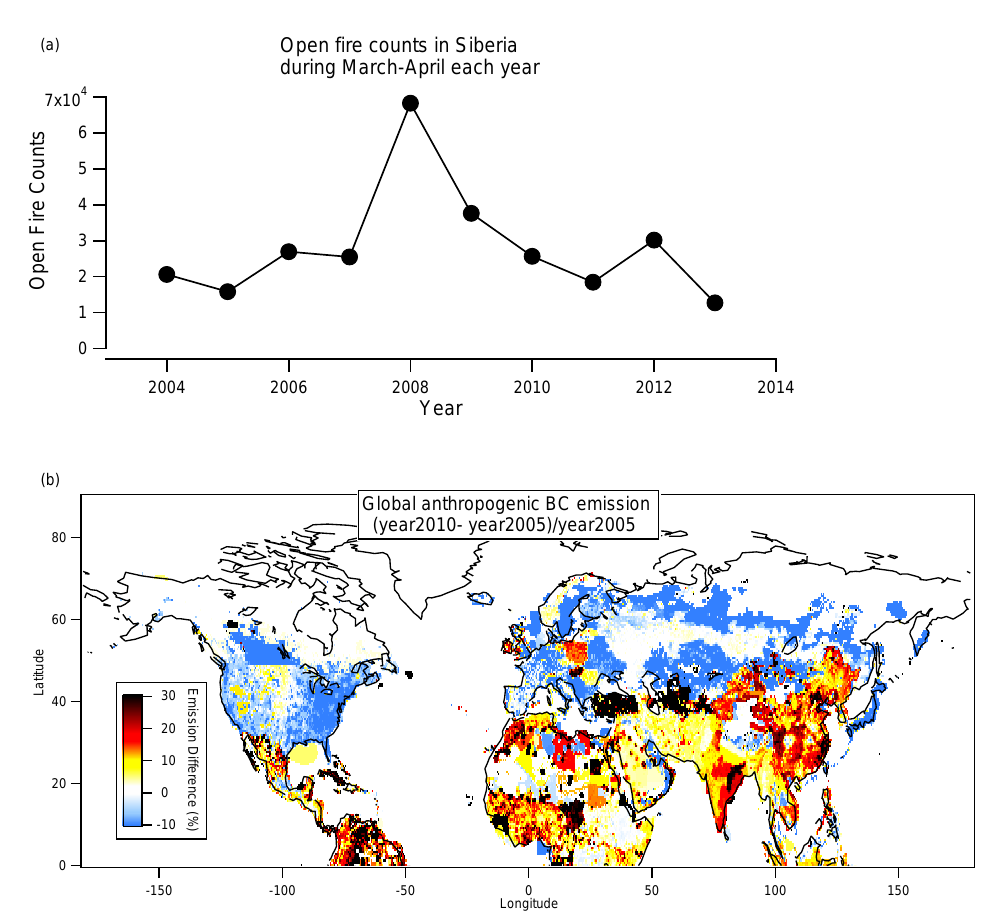
Figure 12. (a) Fire counts from FINN in Siberia region (50–70 ◦ N, 30–180 ◦ E) during March and April from 2004 to 2013. (b) Percentage difference between total anthropogenic BC emissions from the ECLIPSE global BC inventory in 2010 and